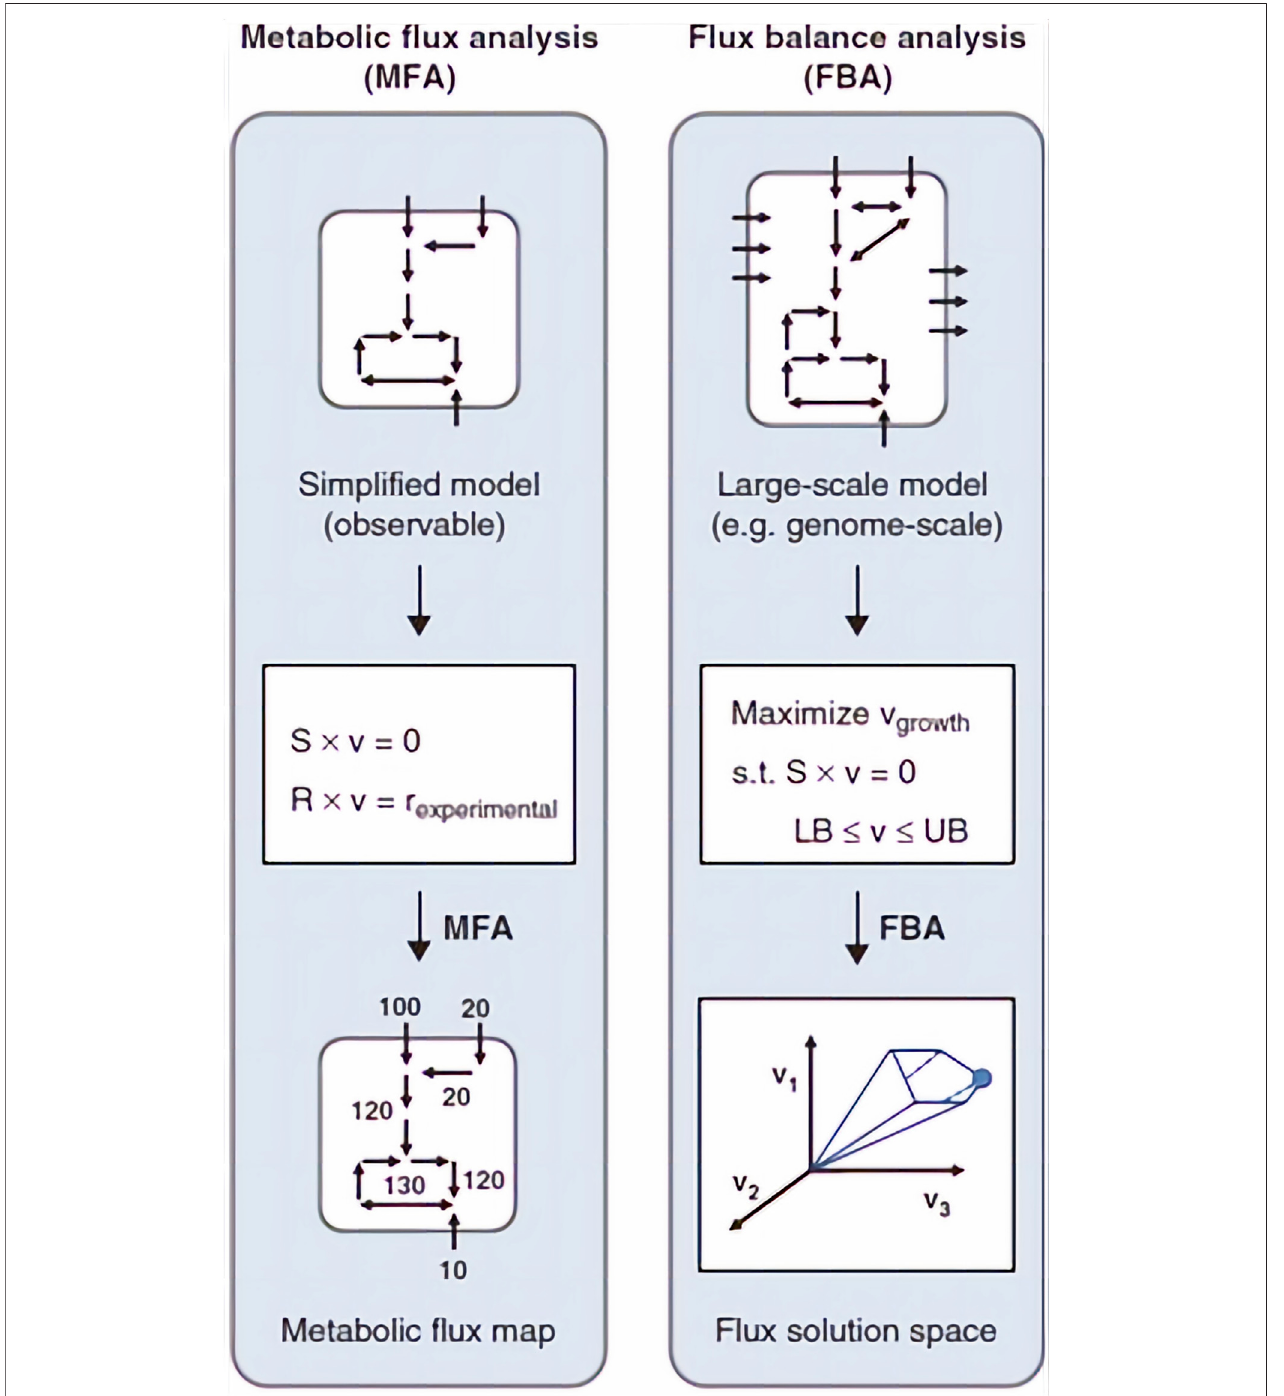
FIGURE5| ThebasicsofMFAandFBAapproaches. S isthestoichiometricmatrix, v isthe fl uxvector,ristheexternalmetabolicrates.InMFA, fl uxesarecalculated by fi ttingextracellularratesmeasured experimentally.InFBA,a fl uxsolutionspaceisdeterminedbyassumingabiologicalobjective,forexample,maximizationofgrowth rate, and solving a linear optimization problem. Adapted with permission from (Antoniewicz, 2015).